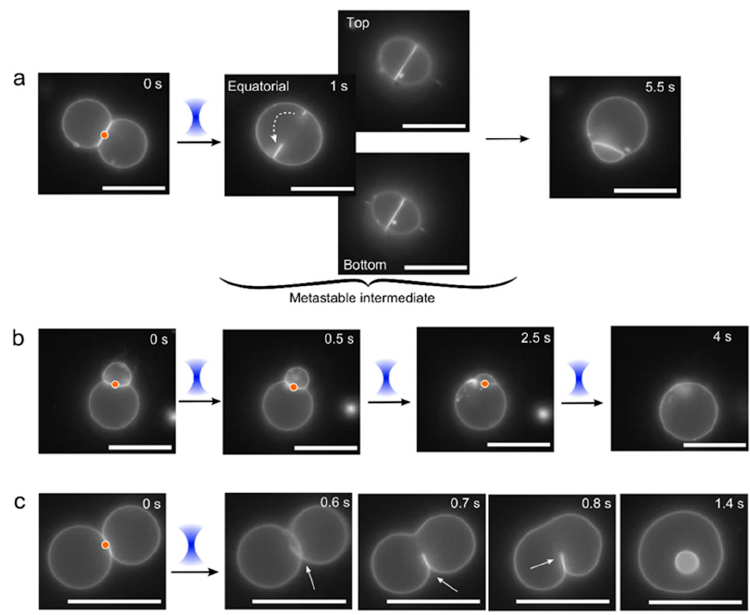
Figure 5. Post-fusion morphologies and intermediate structures. Under osmotically balanced conditions (0.75 M sucrose internally; 0.35 M glucose and 0.2 M NaCl externally) several alternative non-clean fusion events were occasionally observed after application of the laser (red dot and blue cone), including: ( a ) A meta-stable pore of c. 3 µm diameter in the bilayer partition, which after c. 5s rearranged (dotted arrow) to reform the interface membrane. ( b ) Quick opening and closing of a pore upon continuous laser illumination, after each event a portion of the membrane of one vesicle was subsumed into the other, with the formation of a single vesicle at the end. ( c ) An exposed pendant interface membrane (white arrow), which rearranged and reconnected with itself to yield in an inner vesicle. Scale bar = 5 µm.